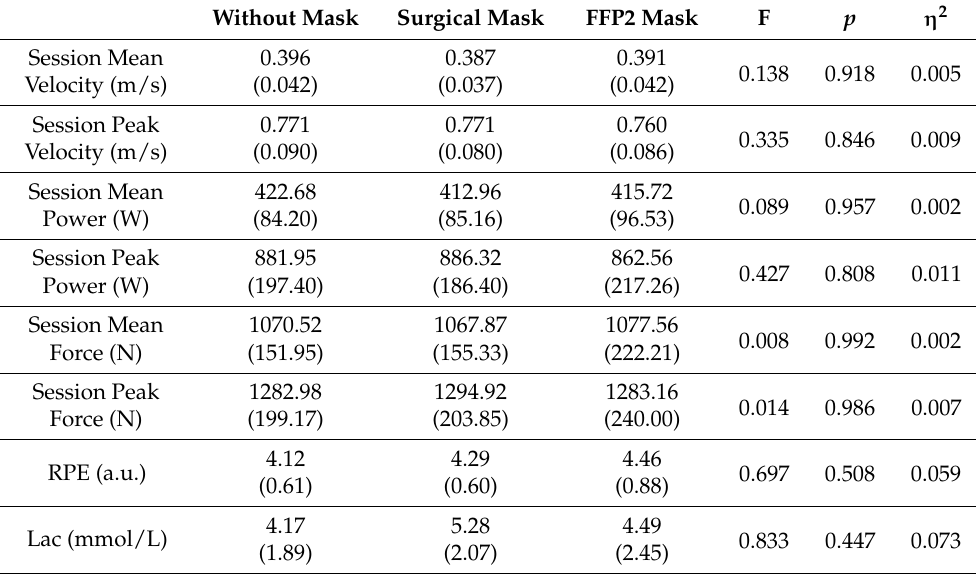
Table 1. Blood lactate concentration, rating of perceived exertion, and strength variables results after each training condition.